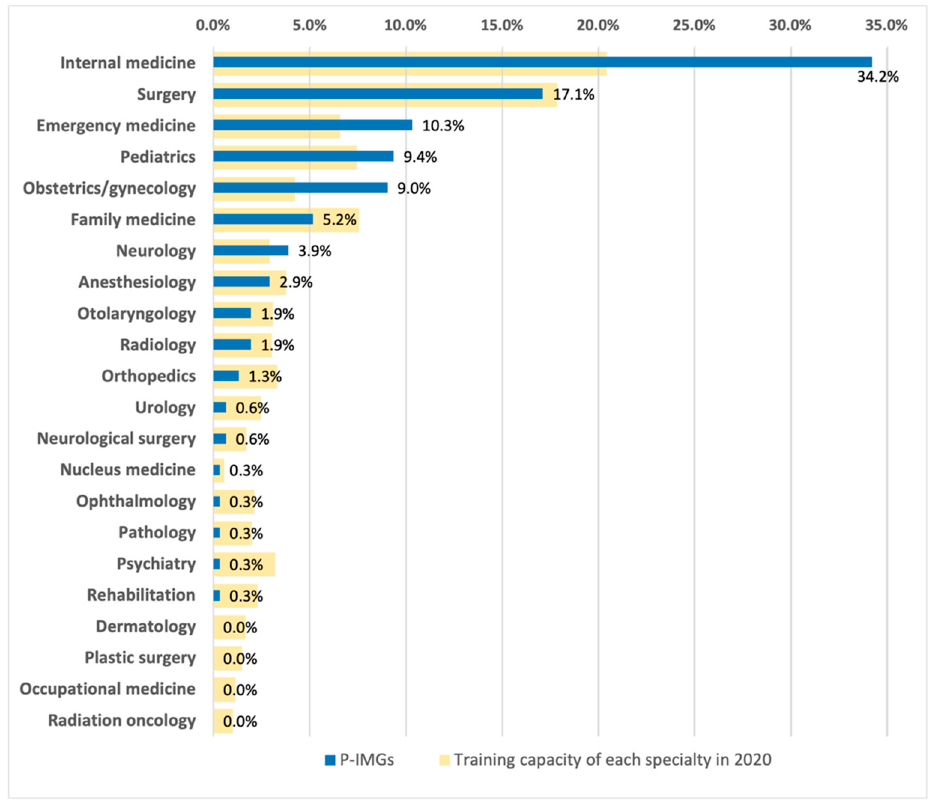
Figure 2. The distribution of the specialties chosen for training by Taiwanese who graduated from Polish medical schools (P-IMGs) between 2000–2020, compared with the training capacity of each specialty in a year (2020) in Taiwan. Table 1. The distribution of hospital levels chosen by Taiwanese students who graduated from Polish medical schools (P-IMGs) during 2000–2020, for their residency training, as well as the urbanization level of the area in which they were trained. (%, n = 306).